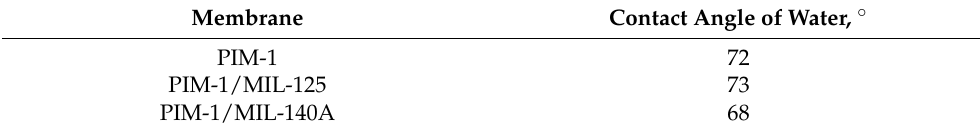
Table 2. Contact angle of water for nanofiltration-supported PIM-1 and PIM-1/MOFs membranes.